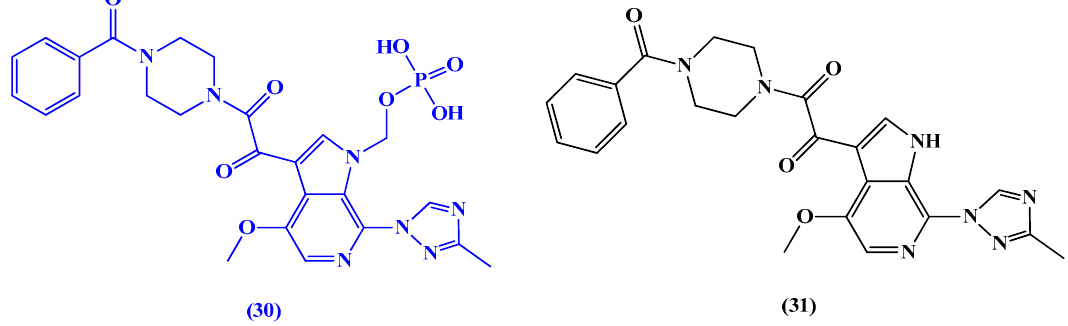
Figure 15. Chemical structures of the prodrug fostemsavir (BMS-663068) ( 30 ) and temsavir ( 31 ).